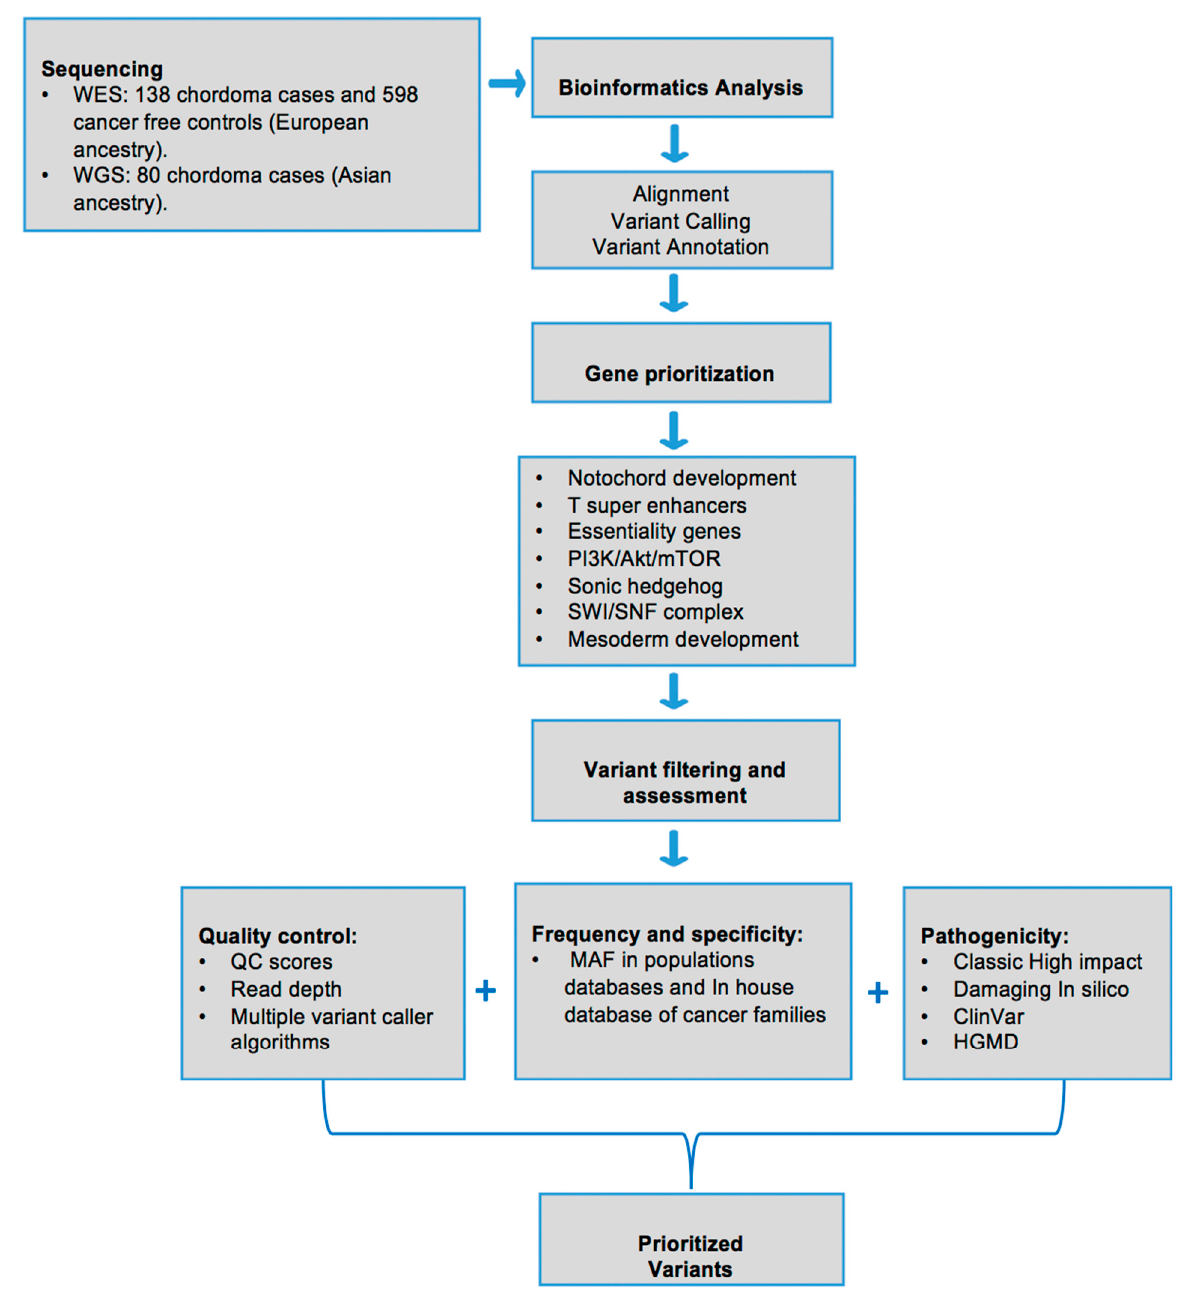
Figure 1. Overview of study samples and prioritization pipeline to evaluate rare and potentially pathogenic variants in genes of interest for chordoma.